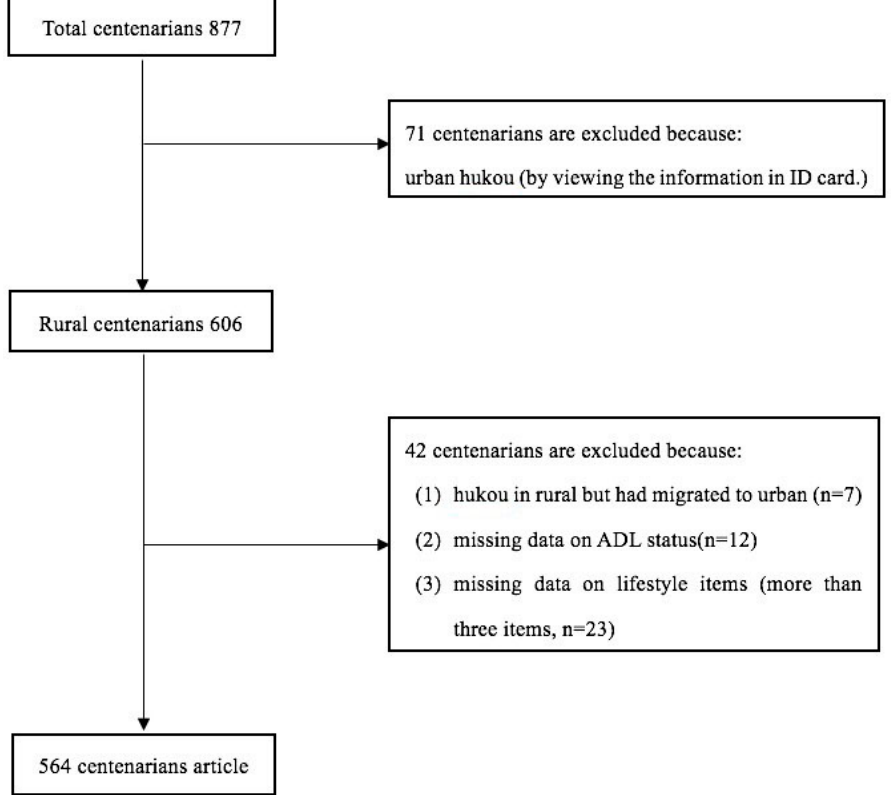
Figure 1. Flowchart of the stepwise selection process of centenarians.